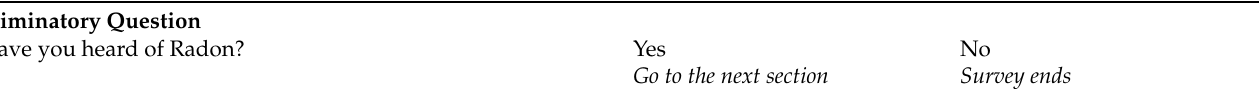
Table 1. Survey presented through GOOGLE FORMS to assess the perception of risk associated with exposure to Radon. Eliminatory Question Have you heard of Radon? Yes